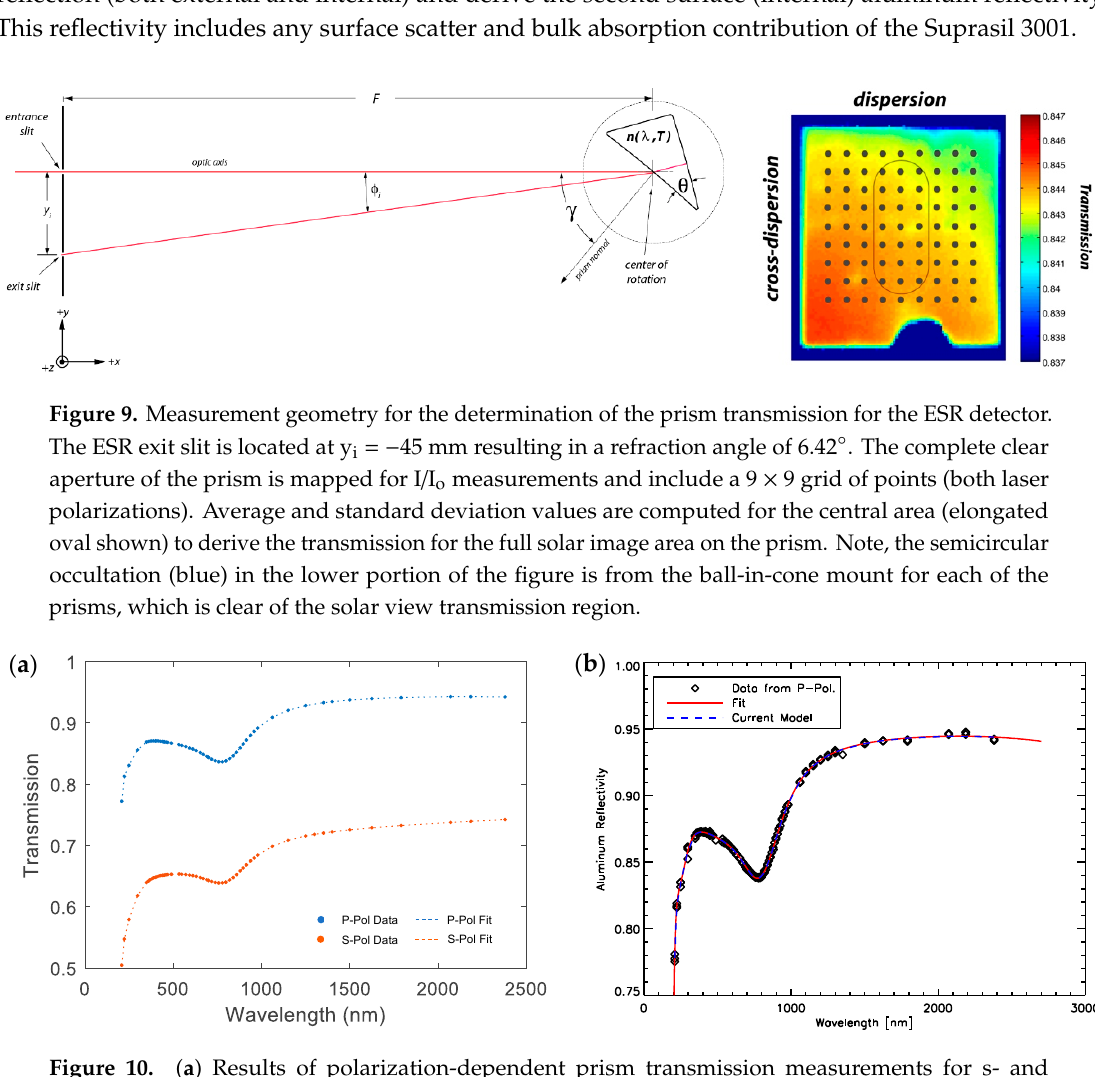
Figure 10. ( a ) Results of polarization-dependent prism transmission measurements for s- and p-polarized laser light. ( b ) Second-surface aluminum reflectivity derived from the p-polarized transmission data and removal of the calculated Fresnel reflection contributions (see text).